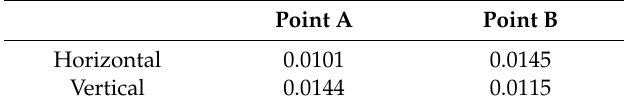
Figure 14. Time course of displacements for shock absorber function (12): ( a ) horizontal displacement of point A, ( b ) vertical displacement of point A, ( c ) horizontal displacement of point B, ( d ) vertical displacement of point B. Table 4. Mean-squared errors of displacements for shock absorber function (12) (mm 2 ).